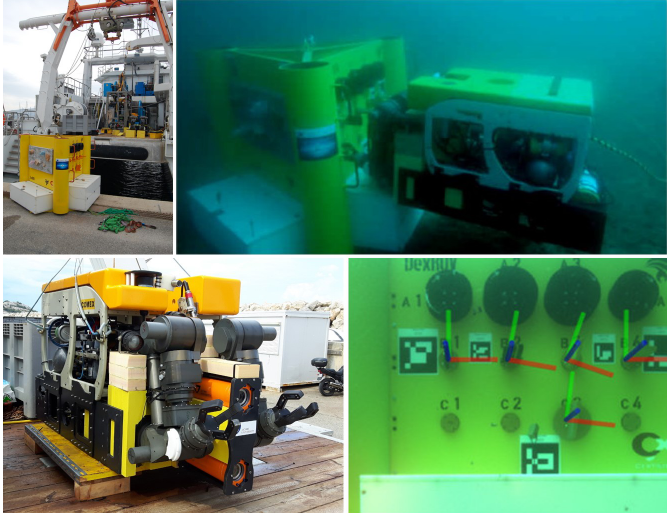
Figure 10. The target object used in the experiments is a mock-up panel including elements from the context of underwater oil- and gas-production ( top , left ). The DexROV system ( bottom , left ) interacts with the panel ( top , right ), for example, based on machine perception of valve states ( bottom , right